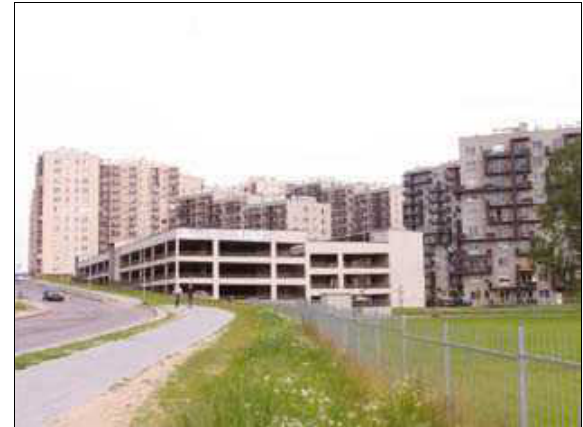
21 pav. Dau­giabu­čių gyvenamųjų namų kvartalas „Perkūnkiemis“ (Ua­b „a­rchitektūros kūrybinė gru­pė“) Fig. 21. blocks of flats in “Perkūnkiemis“ qu­arter. Ua­b “a­rchitektūros kūrybinė gru­pė“